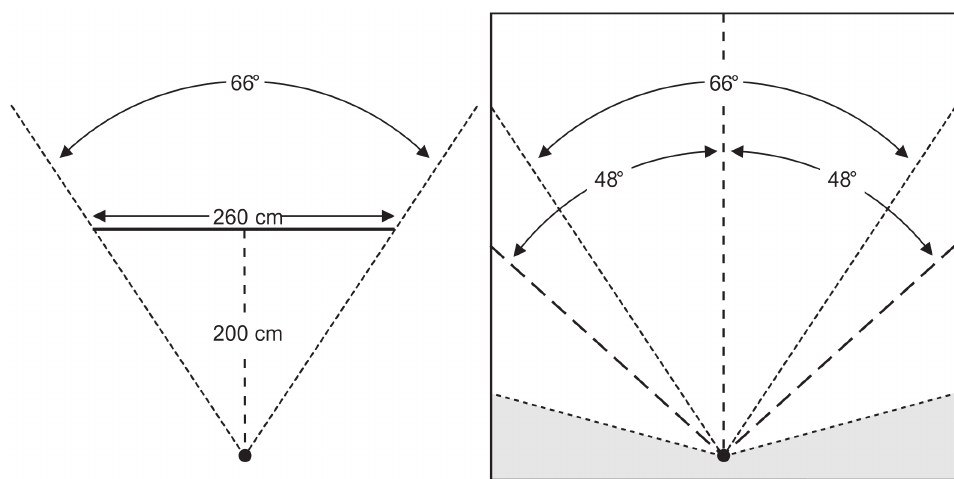
Figure 7. Experiment 2: The observer’s position relative to the projection screen (left-hand side) and relative to the smallest virtual room (right-hand side). Within the virtual room, the grey shaded area was not visible to observers.